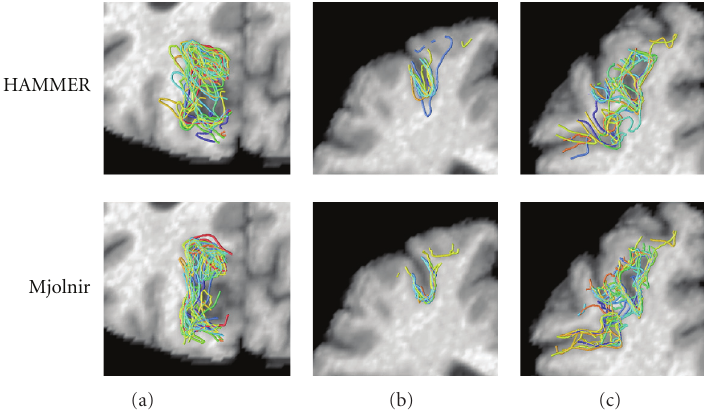
Figure 15: A total of 18 images were registered to a 19th template image. Manually labeled sulci on each of the subjects were deformed and superimposed to see the distribution after registration using HAMMER (top row) and Mjolnir (bottom row). (a) Parieto-occipital sulcus, (b) Superior frontal sulcus (view 1), and (c) Superior frontal sulcus (view